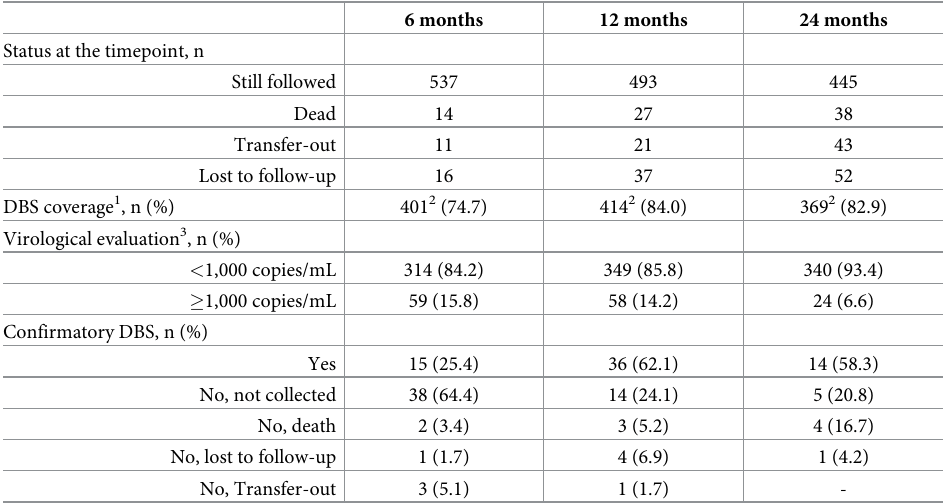
Table 2. Patient status at 6, 12 and 24 months of